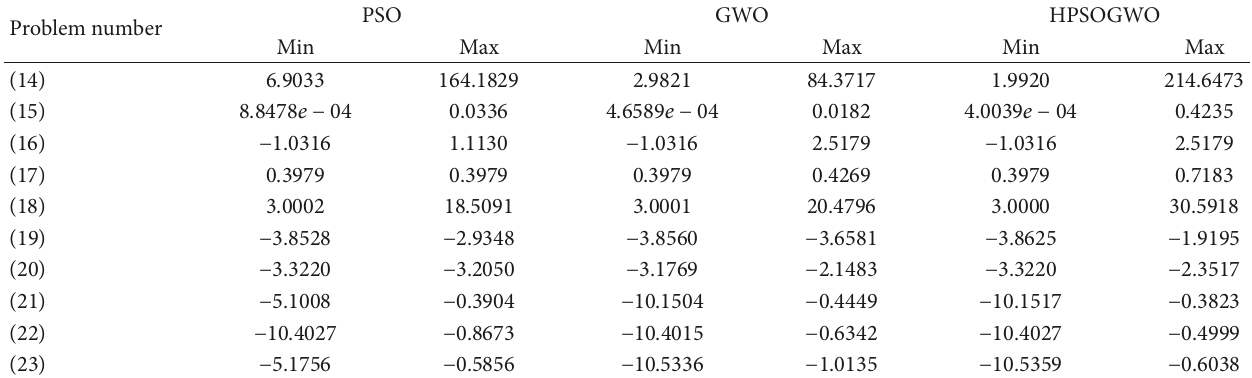
Table 8: PSO, GWO, and HPSOGWO numerical results of fixed-dimension multimodal benchmark functions.